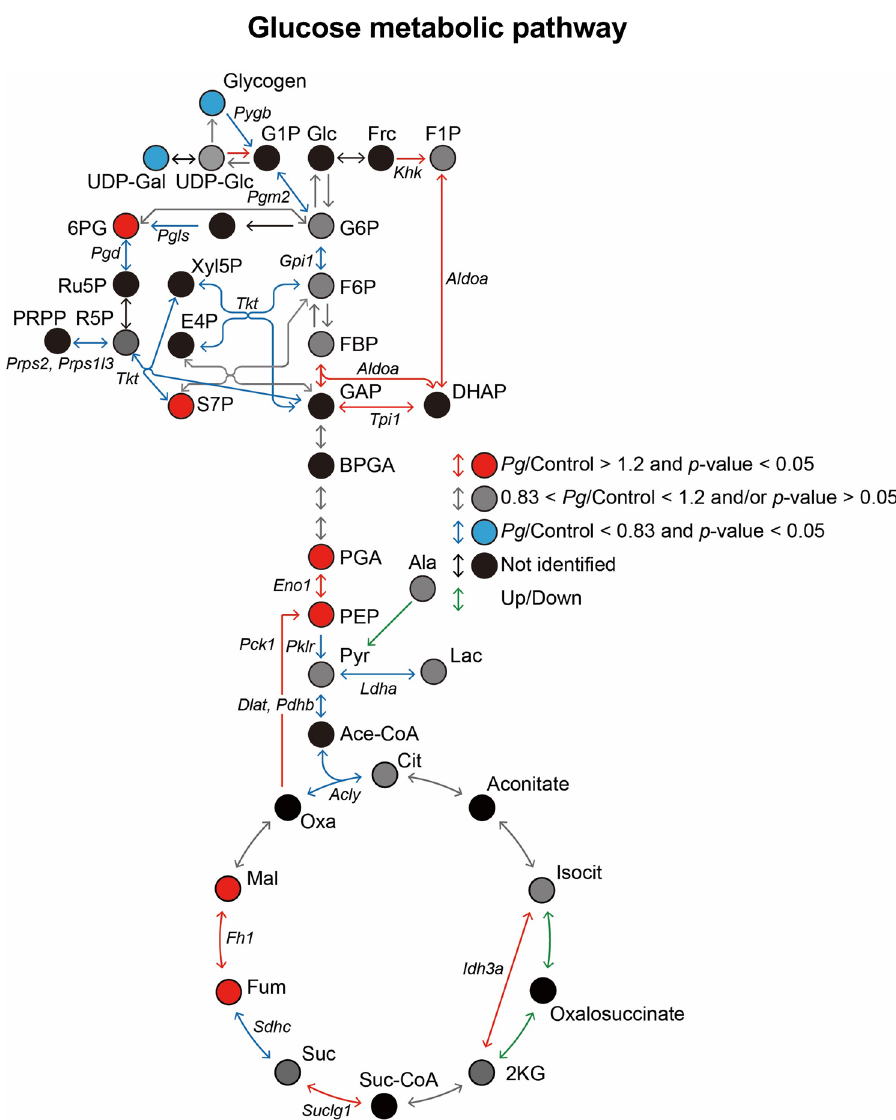
Figure 6. Schematic presentation of the levels of hepatic glucose metabolites and the expression of rate- limiting enzymes of glucose metabolism in Pg - and CMC-treated diabetic mice. Fold changes in the glucose metabolites and enzymes involved in intrahepatic glucose metabolism in the Pg -treated mice, relative to that in the control. Red circles and lines: significant increases. Blue circles and lines: significant reductions. Metabolites that varied substantially and significantly between the Pg -treated mice and the control were identified using these criteria: log 2 fold change >|0.26| and P < 0.05, and P < 0.01. 2 KG, 2-Ketoglutaric acid; 6PG, 6-Phosphogluconic acid; Ace CoA, Acetyl-CoA; BPGA, 1,3-Bisphosphoglycerate; Cit, Citric acid; DHAP, Dihydroxyacetone phosphate; F1P, d-Fructose 1-phosphate; F6P, d-Fructose 6-phosphate; Frc, d-Fructose; G1P, d-Glucose 1-phosphate; G6P, d-Glucose 6-phosphate; GAP, Glyceraldehyde 3-phosphate; Glc, d-Glucose; Isocit, Isocitric acid; Lac, Lactic acid; MAL, Malic acid; Oxa, Oxaloacetic acid; PEP, Phosphoenolpyruvic acid; PGA, 2-Phospho-d-glyceric acid/3-Phospho-d-glyceric acid; Pyr, Pyruvic acid; Suc, Succinic acid; Suc CoA, Succinyl-CoA; UDP-Gal, UDP-alpha-d-galactose; UDP-Glc, Uridine 5 ′ -diphosphate glucose; AGL, Amylo-1,6- glucosidase, 4-alpha-glucanotransferase; Aldoa, Fructose-bisphosphate aldolase A; Dlat, Dihydrolipoyllysine- residue acetyltransferase component of pyruvate dehydrogenase complex, mitochondrial; Pdhb, Pyruvate dehydrogenase E1 component subunit beta; Fh1, Fumarate hydratase-1; Gpi1, Glucose-6-phosphate isomerase 1; Gys2: Glycogen [starch] synthase 2; Ldha, L-lactate dehydrogenase; Pck1, Phosphoenolpyruvate carboxykinase; Pgm2, Phosphoglucomutase-2; Idh3a, Isocitrate dehydrogenase [NAD] subunit alpha, mitochondrial; Suclg1, Succinyl-CoA ligase [GDP-forming] subunit alpha, mitochondrial; Sdhc, Succinate dehydrogenase (ubiquinone) cytochrome b560 subunit; Acly, ATP citrate (pro-S)-lyase; Tpi1, Triosephosphate isomerase